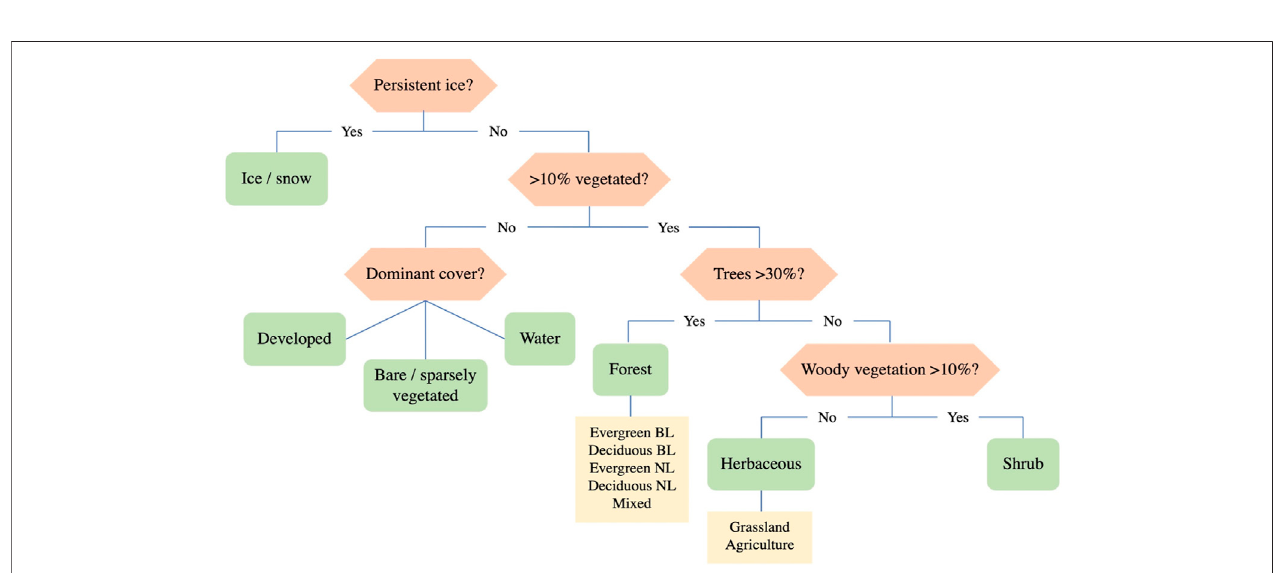
FIGURE 1 | GLanCE dichotomous training data key, legend, and attributes used to assign land cover to training sites. Green boxes show the Level 1 land cover classes that are being mapped for the GLanCE data product; Yellow boxes show additional attributes that are recorded to support Level 2 classi fi cation. BL, broadleaf; NL,